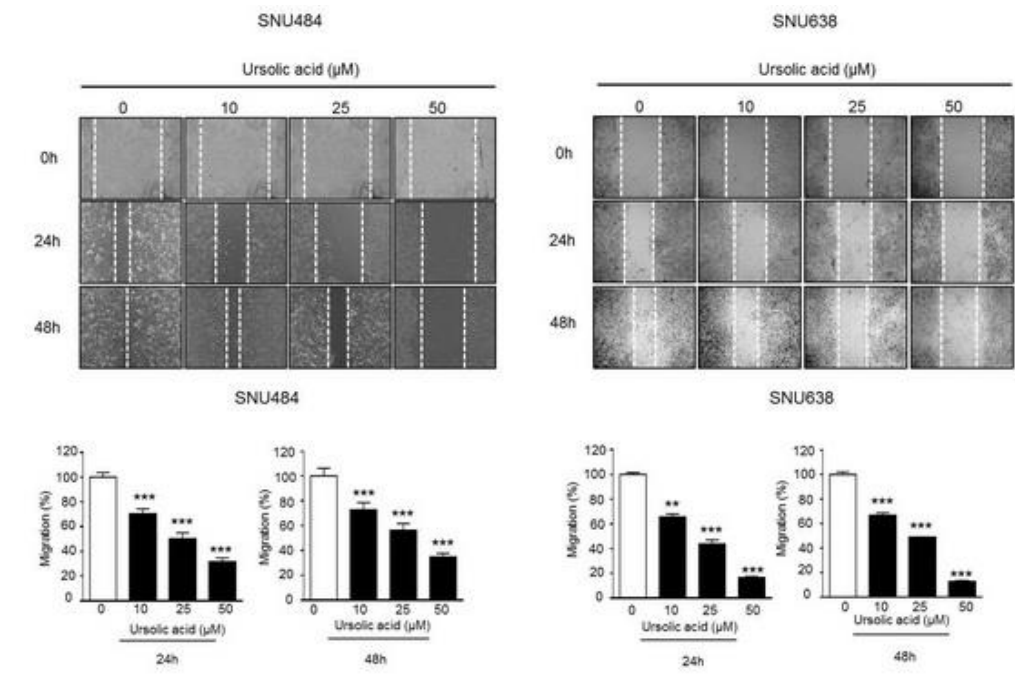
Figure 4. Effect of UA on the migration rates of gastric cancer cells. ( A ) SNU484 and SNU638 cells were treated with UA (0, 10, 25, and 50 µ M), the migratory rates were detected by wound healing assay. UA significantly inhibited the cell migration in a dose-dependent manner both at 24 h and 48 h. Data represent the mean ± SE of three independent experiments. ** p < 0.01 and *** p < 0.001 compared to the control.